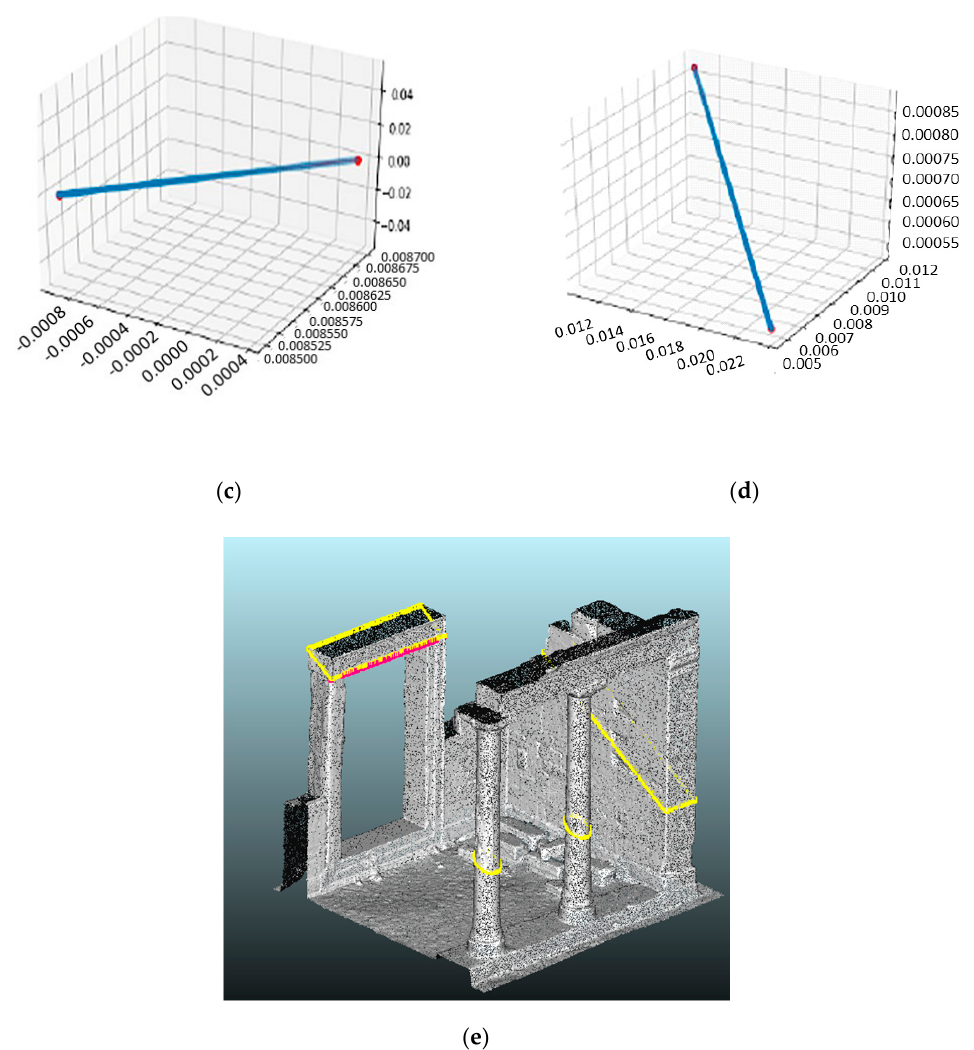
Figure 5. Results of the implementation of the first part of the algorithm to the real-world data. ( a ) the point cloud with 750,000 points, ( b ) the selected 2D edge on one image, ( c ) the 2D line as represented in image space, ( d ) the 2D line transformed and related to global reference system and ( e ) the section of the determined plane with the point cloud